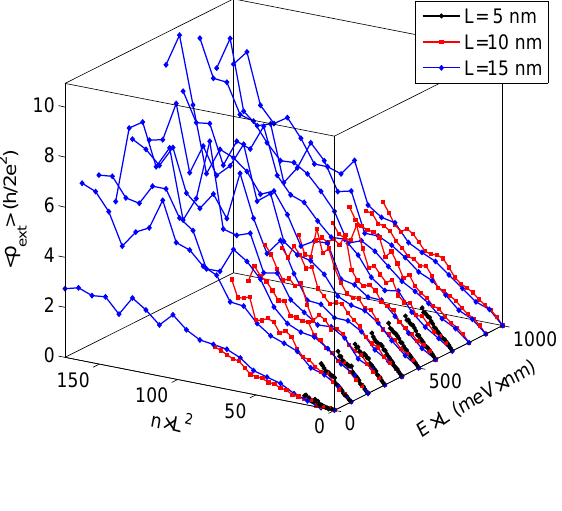
Figure 10. Average extrinsic resistivity for aGNRs with W = 150 nm and L = 5 nm (black lines), L = 10 nm (blue lines) and L = 15 nm (red lines), as a function of E dimensionless parameter n L 2 , where n is here expressed as vacancies per unit ×